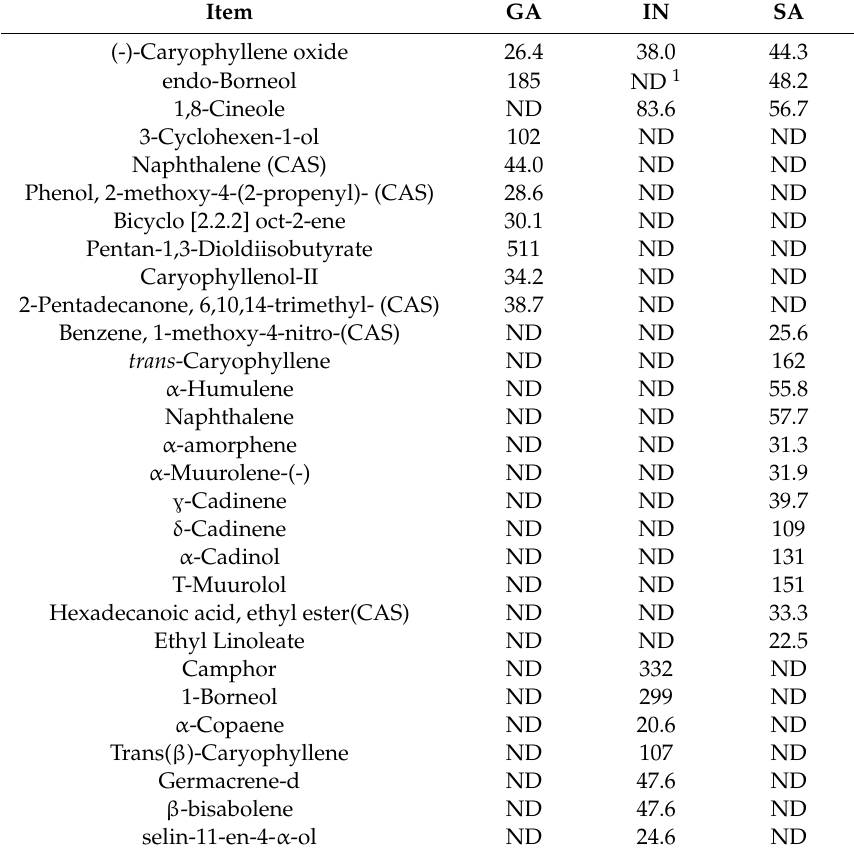
Table 2. The Essential Oil Constituents of Ganghwa (GA), Injin (IN), and San (SA) Korean Native Wormwoods (g kg − 1 ,